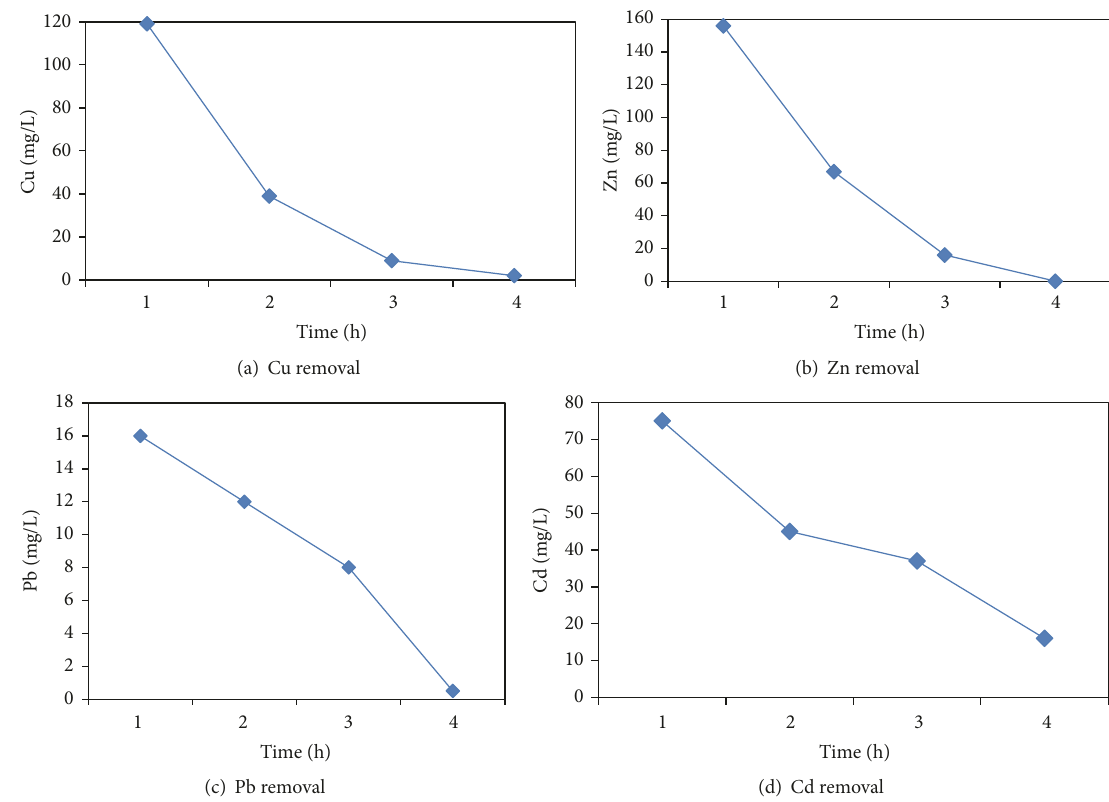
Figure 2: Removal of Cu, Zn, Pb, and Cd in simulated water during 180 minutes of the electrocoagulation process with a current density of 8 mA/cm 2 , volume of 2 L, pH: 5.27–5.81, concentrations [NO 3− ]: 1.29mM, [SO 42− ]: 3.14mM, [Al 3+ ]: 25mM, [Cu 2+ ]: 2.58 mM, [Zn 2+ ]: 3.70 mM, [Pb 2+ ]: 0.57 mM, and [Cd 2+ ]: 0.72 mM [52].